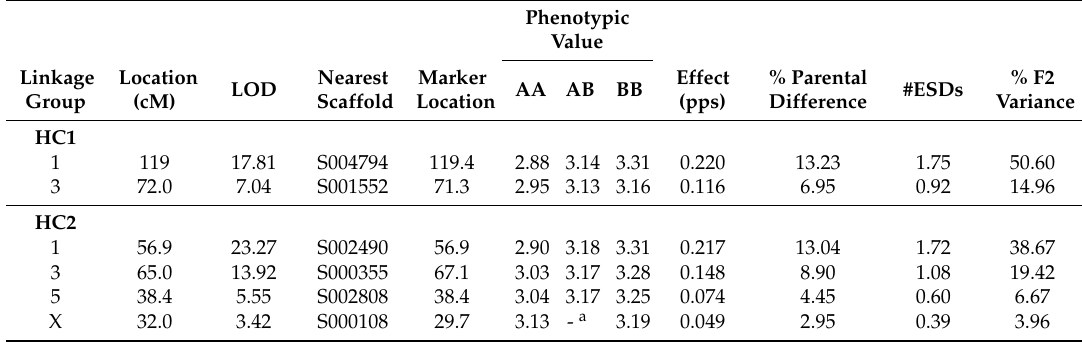
Table 2. Quantitative trait locus (QTL) results from HC1 and HC2. The QTL were mapped using the maps for the 94 HC1 and 136 HC2 F2 individuals. LOD—log-of-odds. The A and B alleles denote L. cerasina and L. eukolea alleles, respectively. All of the QTL effects (in pulses per second) are significantly different from zero. ESD—environmental standard deviation.